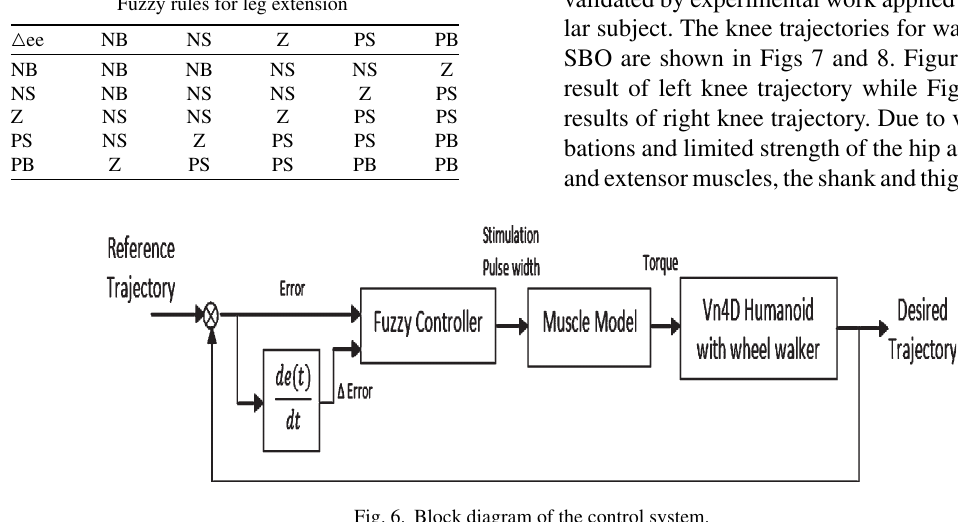
Fig. 6. Block diagram of the control